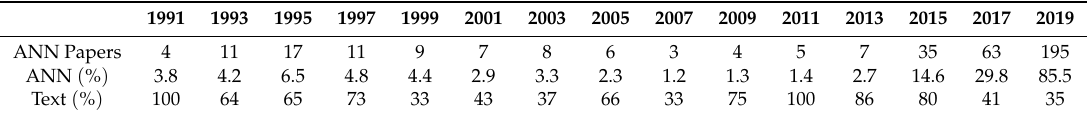
Table 1. Distribution of papers using neural network based approaches published in the proceedings of the International Conference of Document Analysis and Recognition (ICDAR) conference series from 1991 to